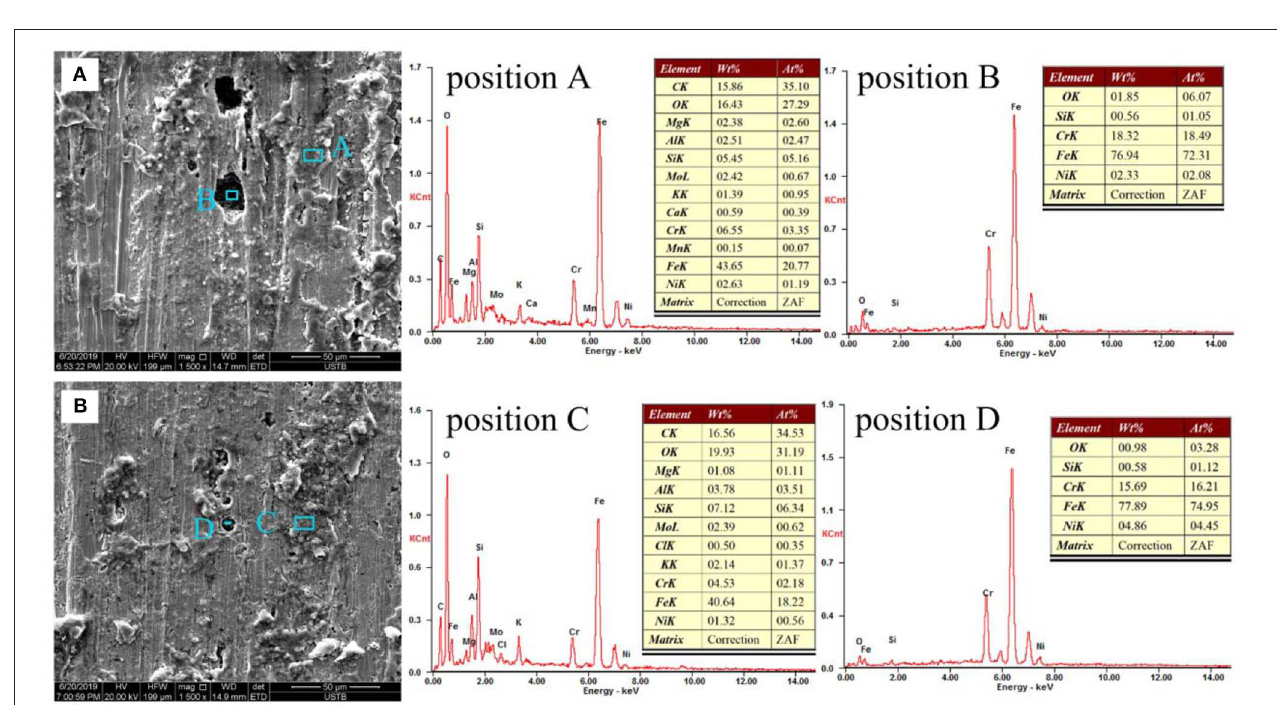
FIGURE 4 | The microscopic morphologies and EDS analysis of the (A) Bare sample; (B) Pre-passivated sample after 5 years exposure.